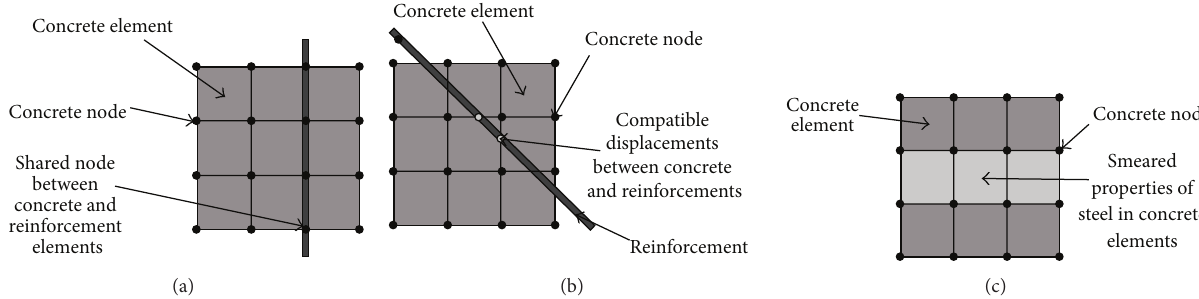
Figure 6: Reinforcement modelling techniques: (a) discrete, (b) embedded, and (c) smeared [4].